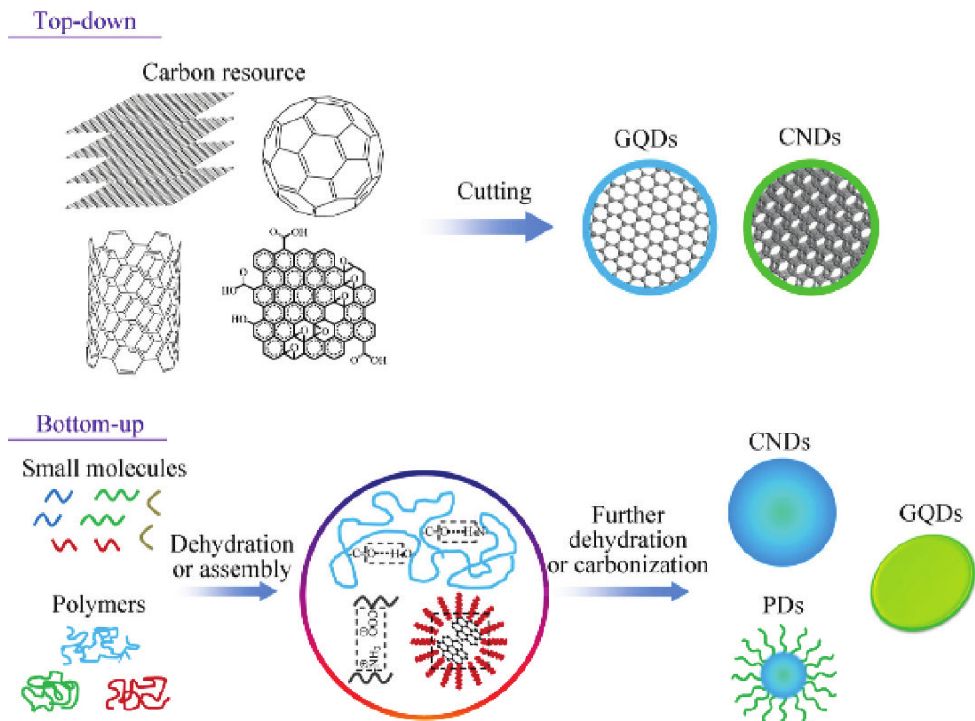
Figure 5: Synthesis method of CDs. Reprinted image with permission from Ref. [57], Copyright 2015, Springer